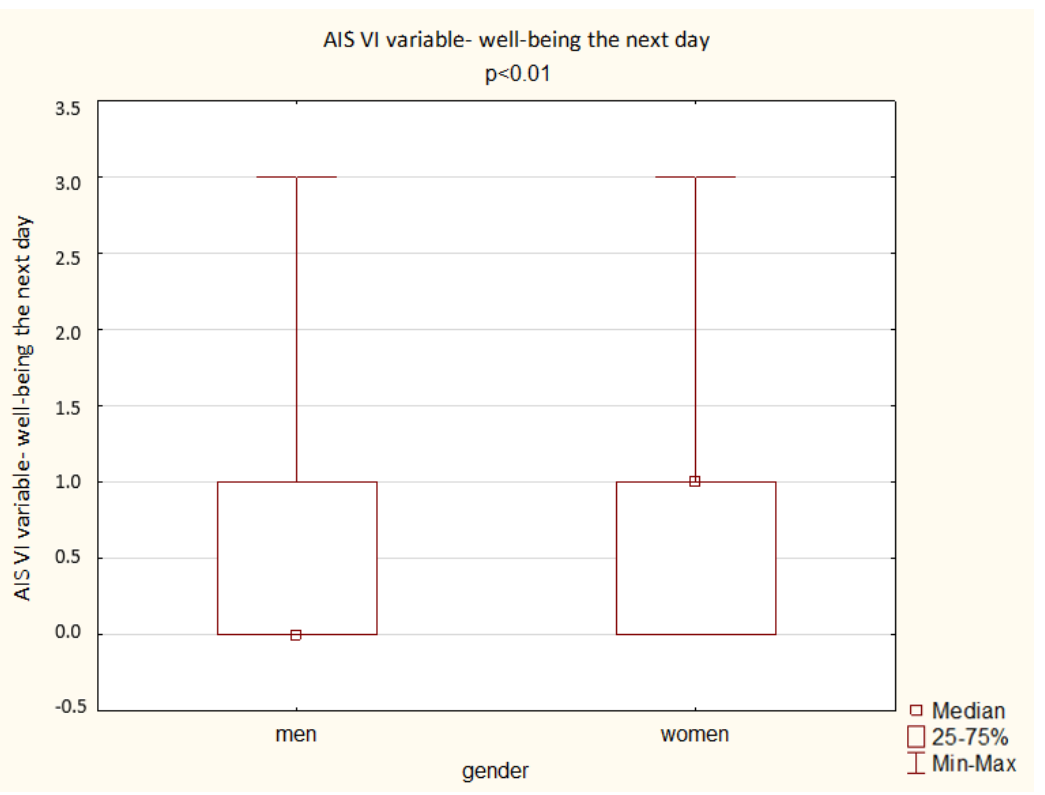
Figure 4. Patient results in the AIS VI variable — well-being the next day (Mann – Whitney U test).